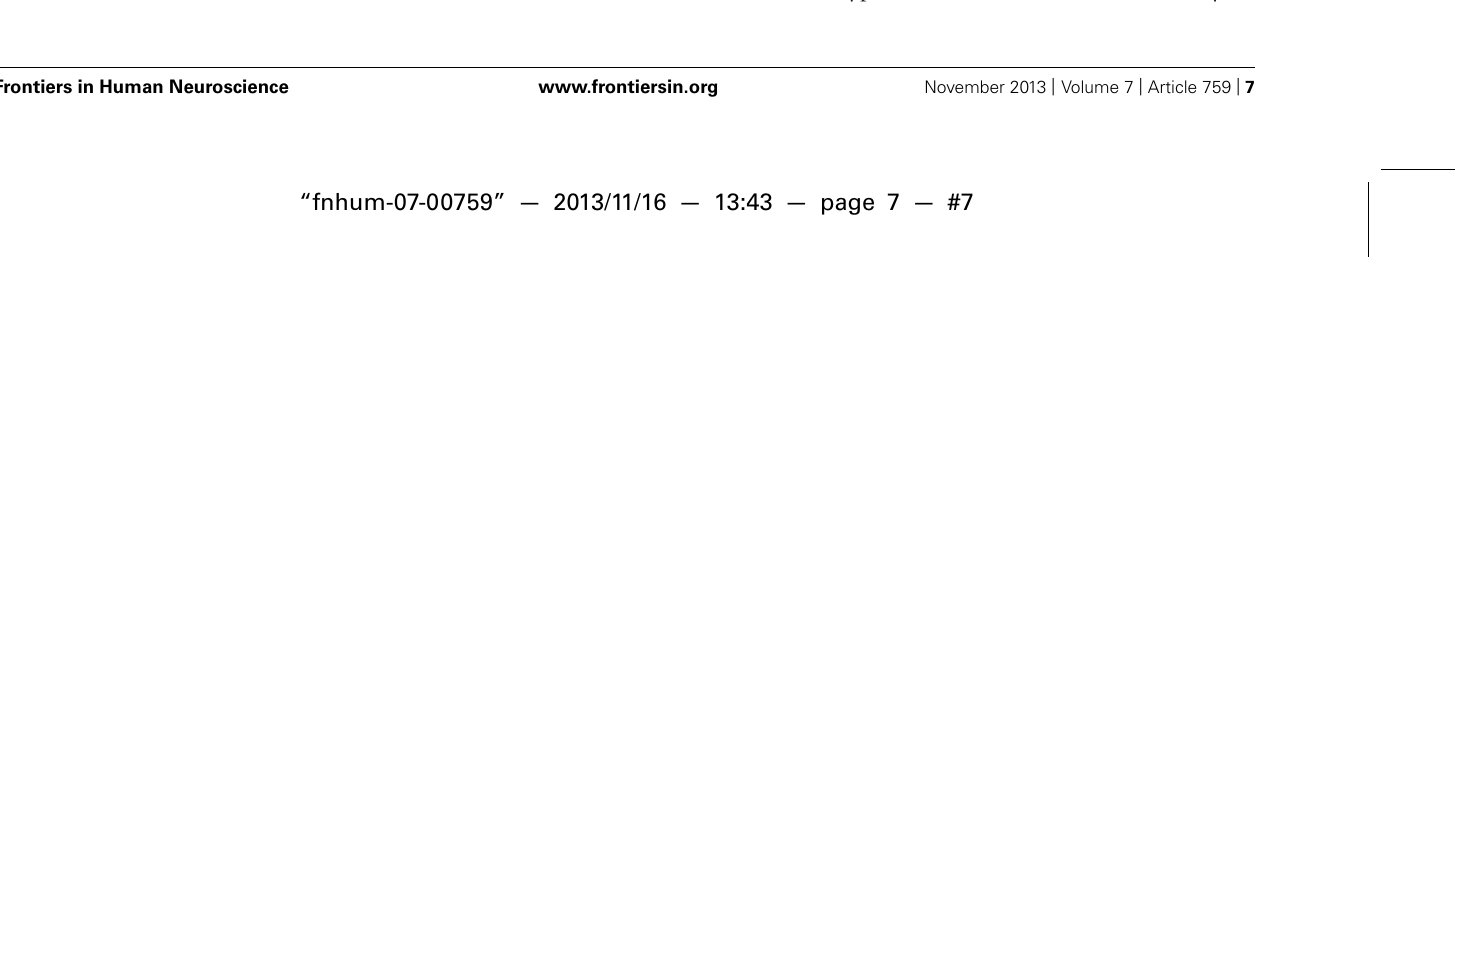
FIGURE 2 | Mismatch negativity response averaged across word conditions ( bakes / beaks , baker / beaker , bacon / beacon ): (A) sensor level (EEG, gradiometers and magnetometers) and (B) source level (L2 minimum norm estimate using combined MEG + EEG)